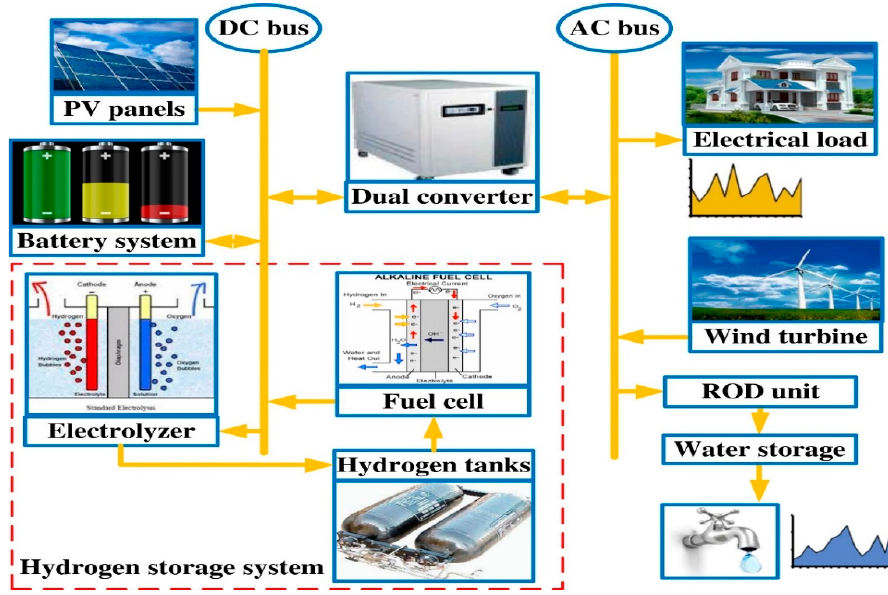
Figure 15. Illustration of six hybrid renewable energy systems [148], reused with permission from Elsevier (license number 5491450782466).